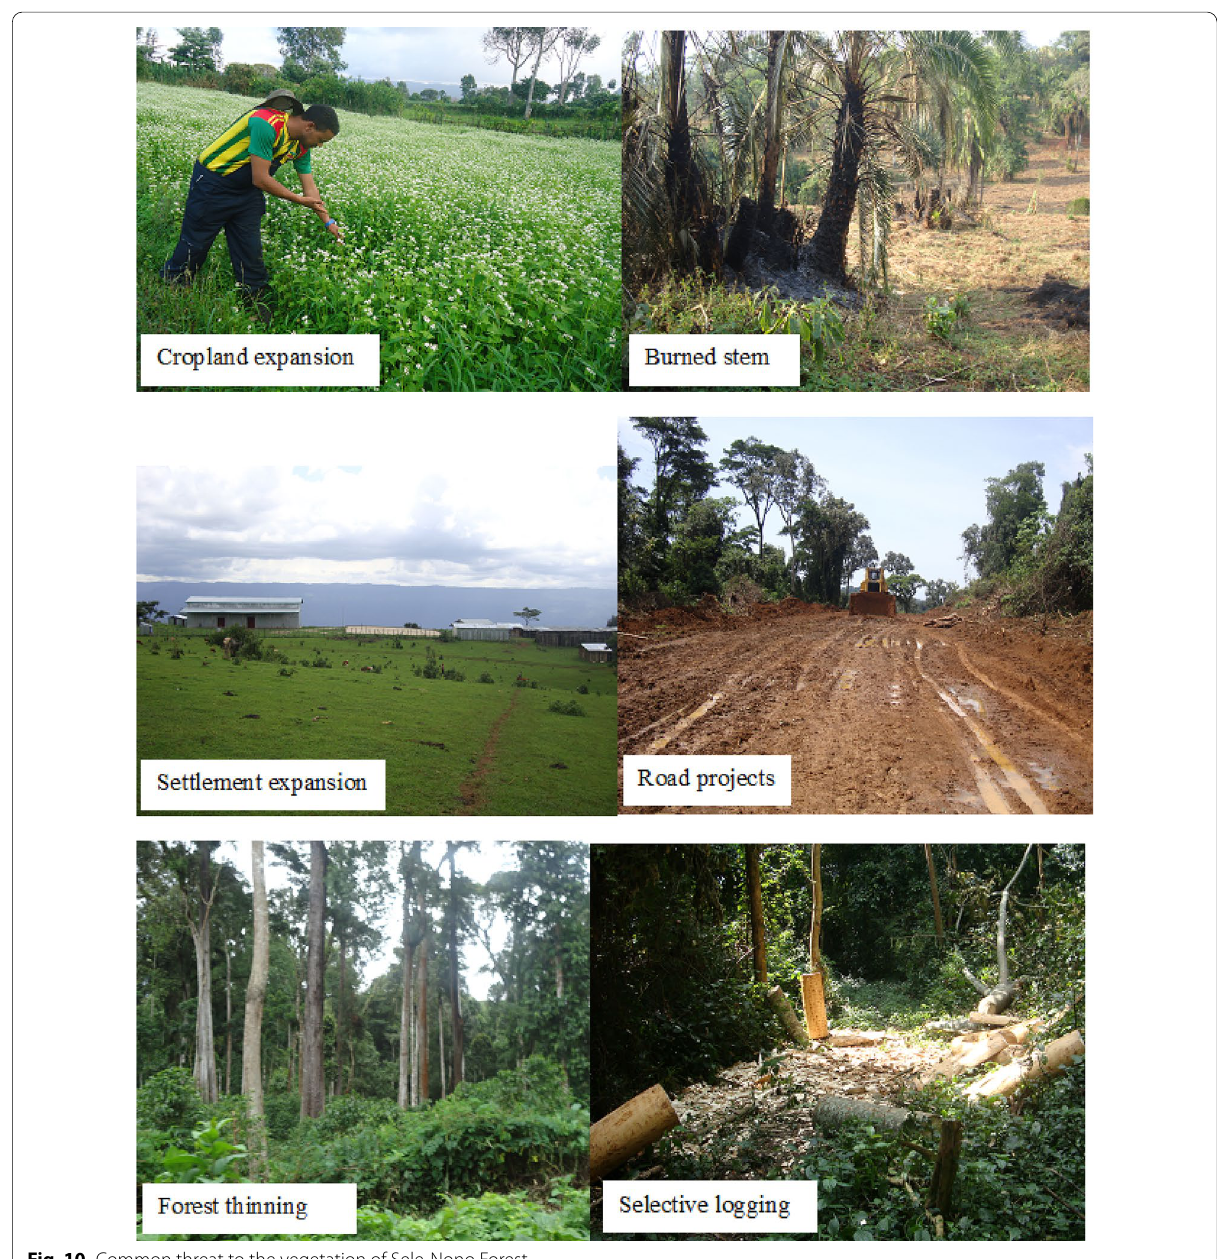
Fig. 10 Common threat to the vegetation of Sele-Nono